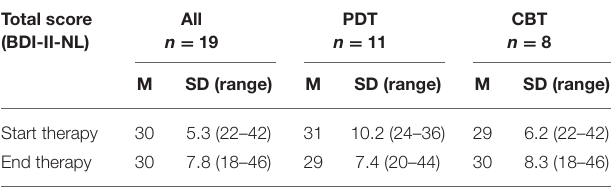
TABLE 2 | Pre-post outcome scores on the